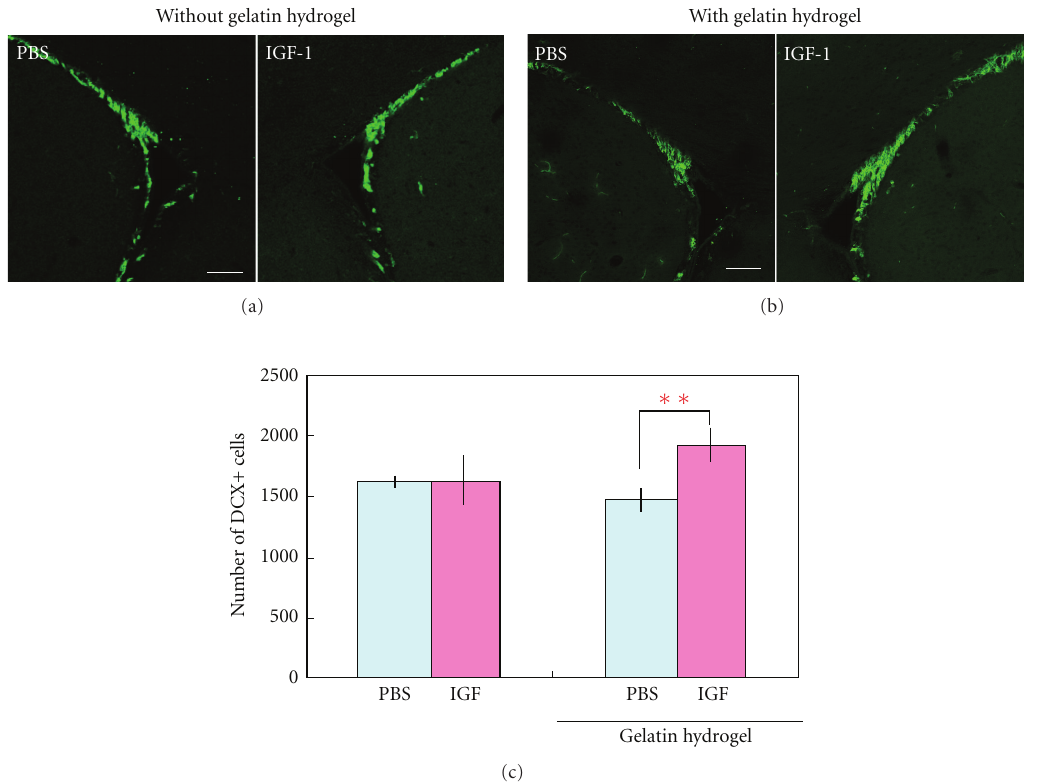
Figure 2: E ff ects of IGF-1-containing gelatin hydrogel on neurogenesis in the SVZ. (a) Coronal sections of brains that received an IGF-1 or PBS injection without gelatin hydrogel 7 days before, showing DCX+ new neurons in the SVZ (green) ( n = 3 animals for each group). (b) Coronal sections of brains that received an injection of microspheres containing IGF-1 or microspheres plus PBS, showing DCX+ new neurons in the SVZ (green) ( n = 5 animals for each group). (c) Quantification of DCX+ cells in the SVZ. Scale bars: 100 µ m (a and b). ∗∗ P < 0 .